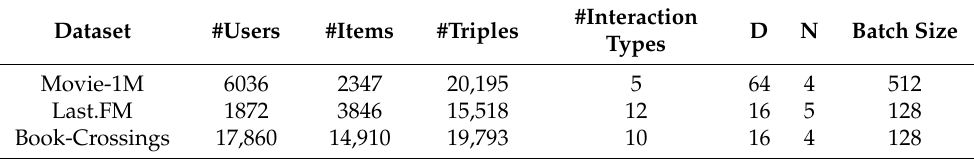
Table 1. Basic data statistics of the dataset and hyperparameter